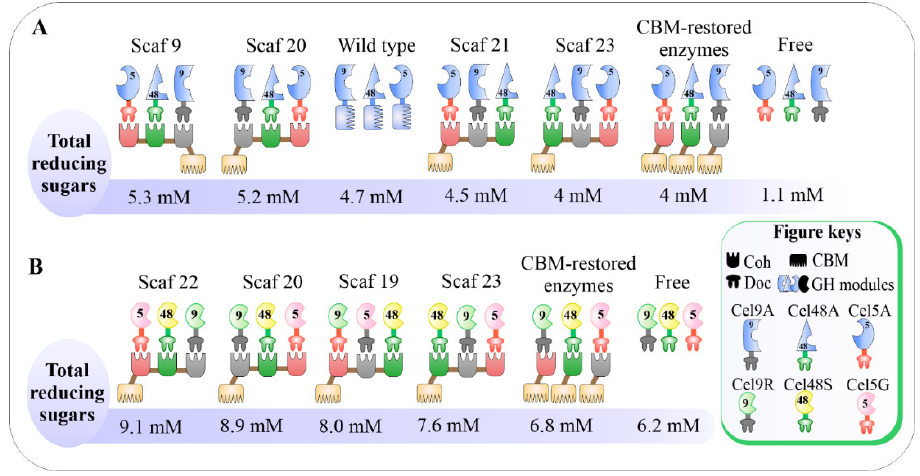
Figure 5. Influences of enzyme positions on activity of chimeric trivalent cellulosomes. ( A ) Hydrolysis of Avicel by T. fusca -based trivalent cellulosomes. ( B ) Avicel degradation by C. thermocellum -based trivalent cellulosomes.